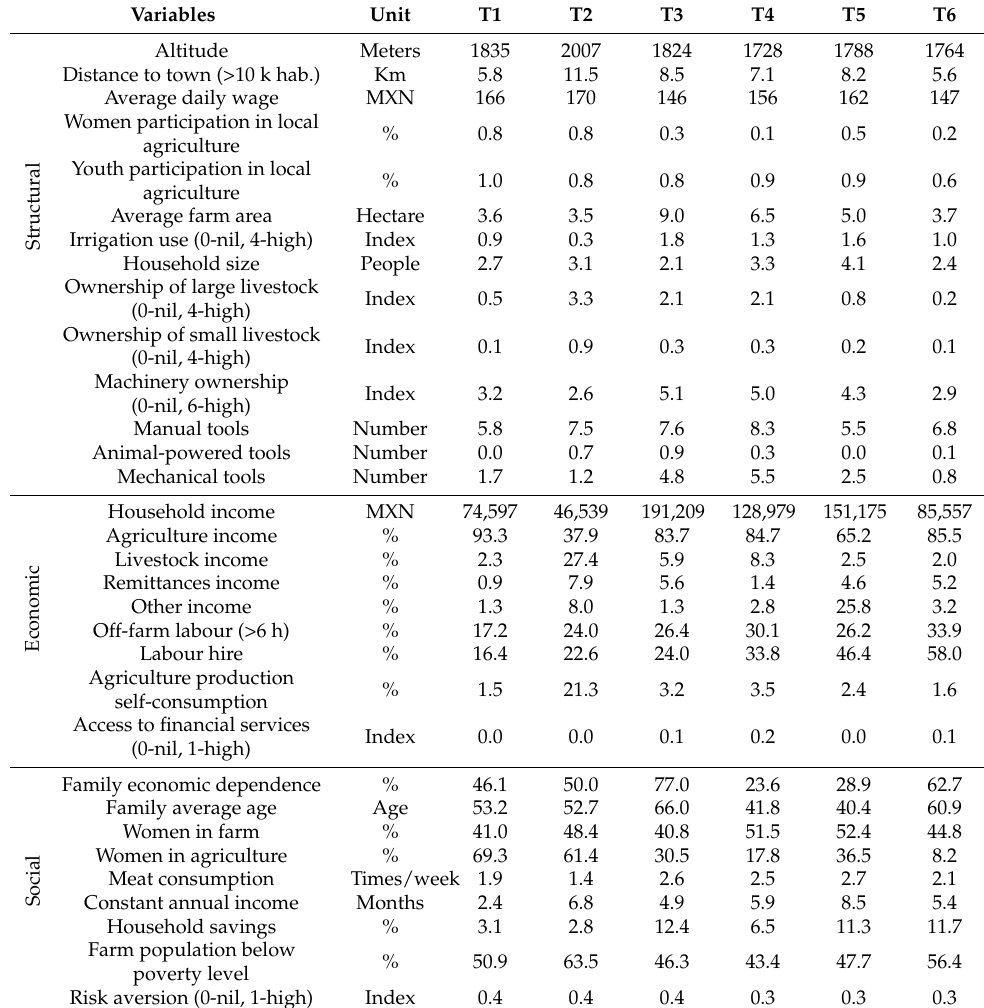
Table A1. Typology of rural production units–Guanajuato 2019 (Source: adapted from